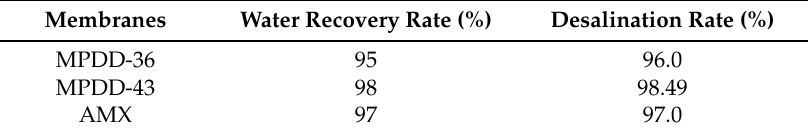
Table 5. Water recovery rate and desalination rate of studied membranes.